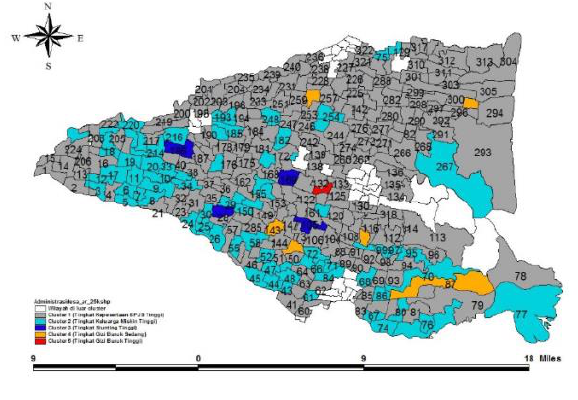
Figure 5: Village Grouping in Poverty and Hunger